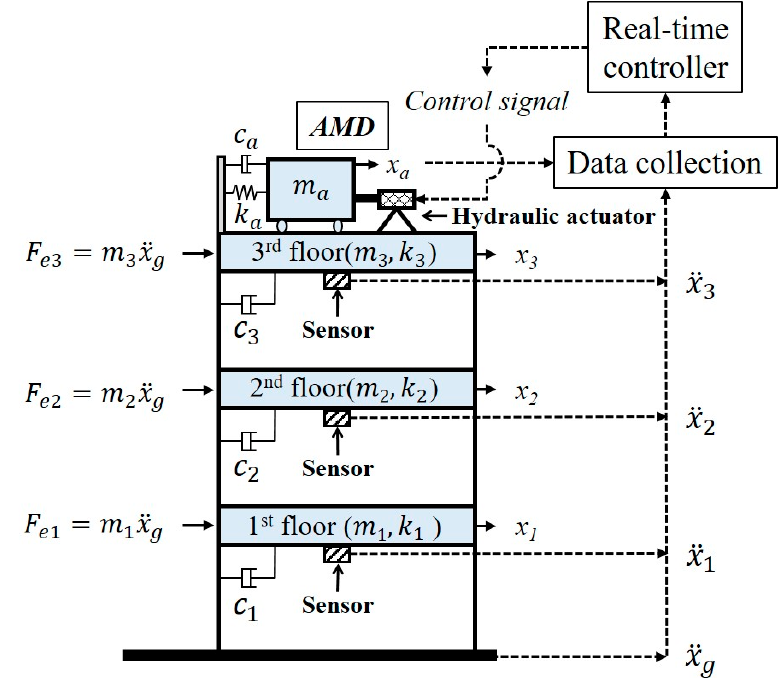
Figure 1. Idealized schematic diagram of a three-story building structure with an active mass damper (AMD).